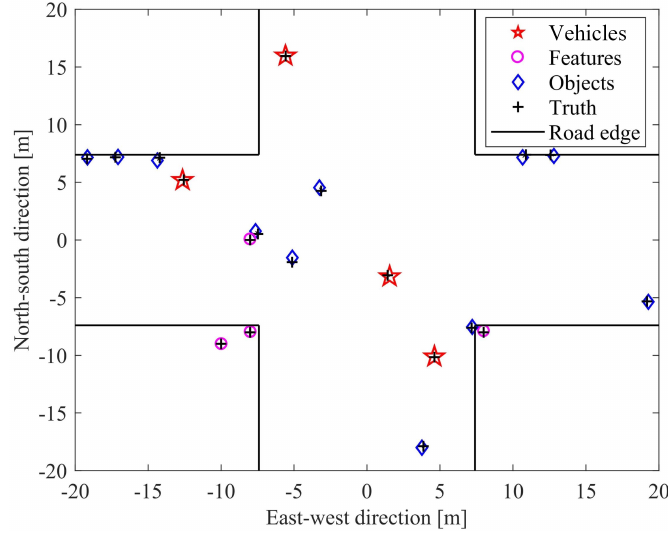
Figure 5. Multiple-target position performance in the urban